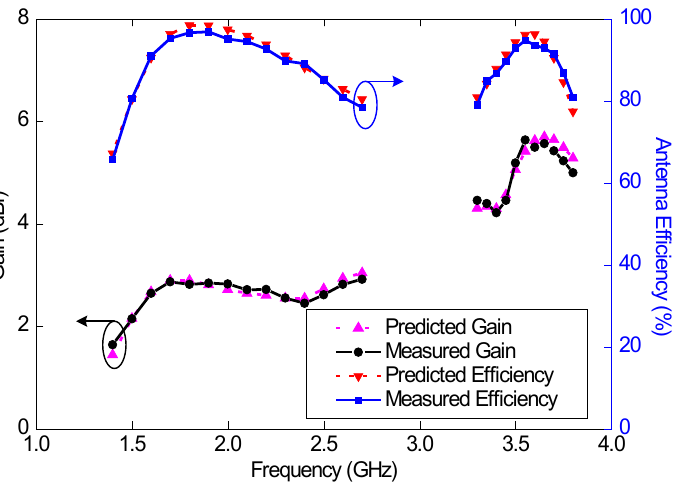
Figure 18. Measured and predicted gains and efficiencies of the wideband antenna